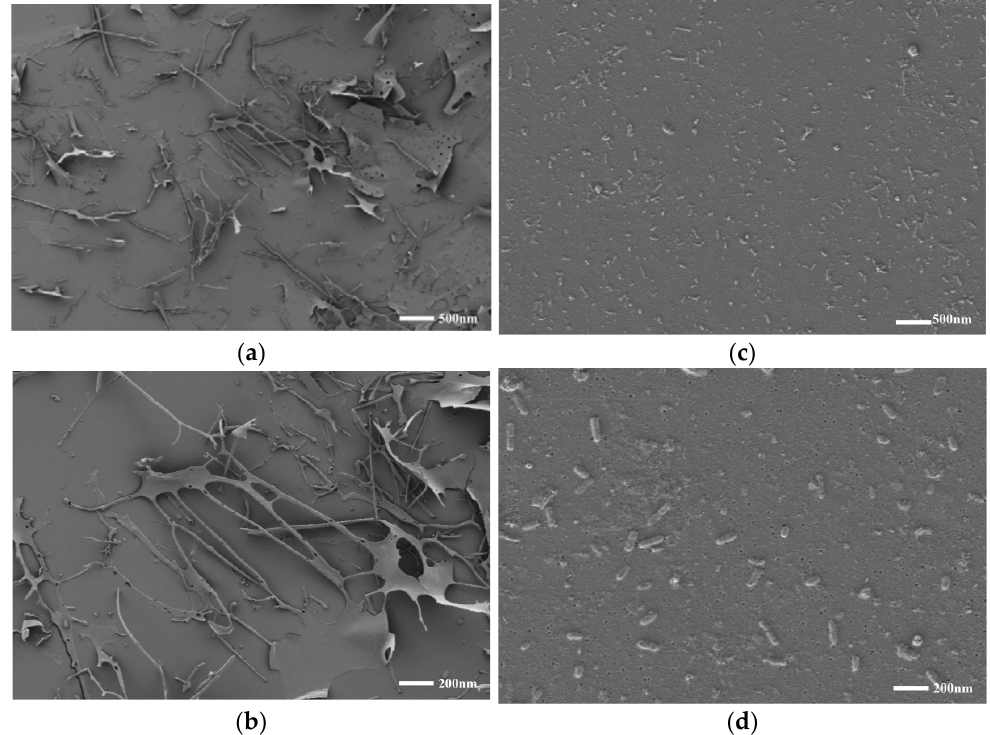
Figure 4. SEM images of AAP ( a , b ) and AAP-NPs ( c , d ) with scale bars of 500 nm and 200 nm, re- spectively